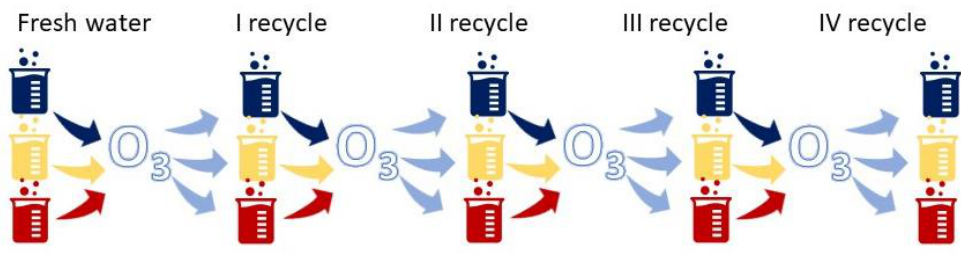
Figure 1. Scheme of the recycling procedure (5 dyeing cycles and 4 ozonation cycles); blue—dyeing with C.I. Reactive Black 5, yellow—dyeing with C. I. Reactive Yellow145, red—dyeing with C.I. Reactive Red 195.